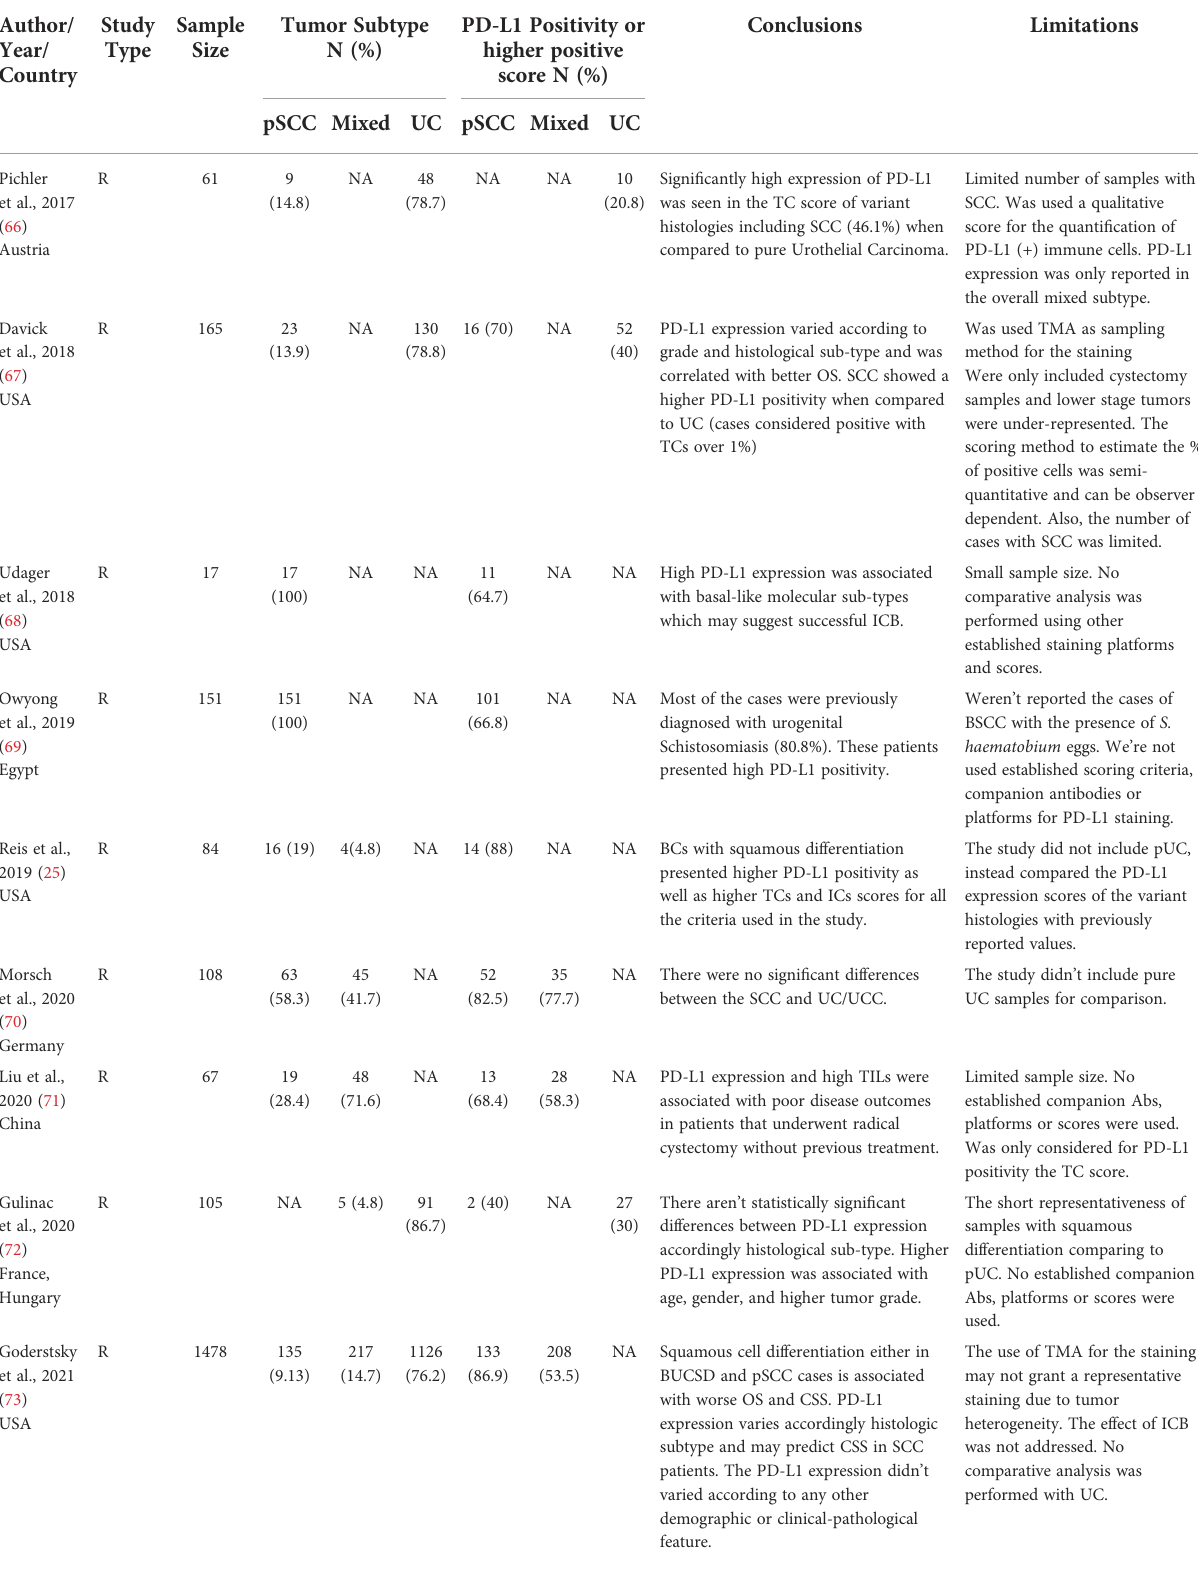
TABLE 1 Summary of most pertinent publications were PD-L1 expression was addressed by IHC accordingly Squamous